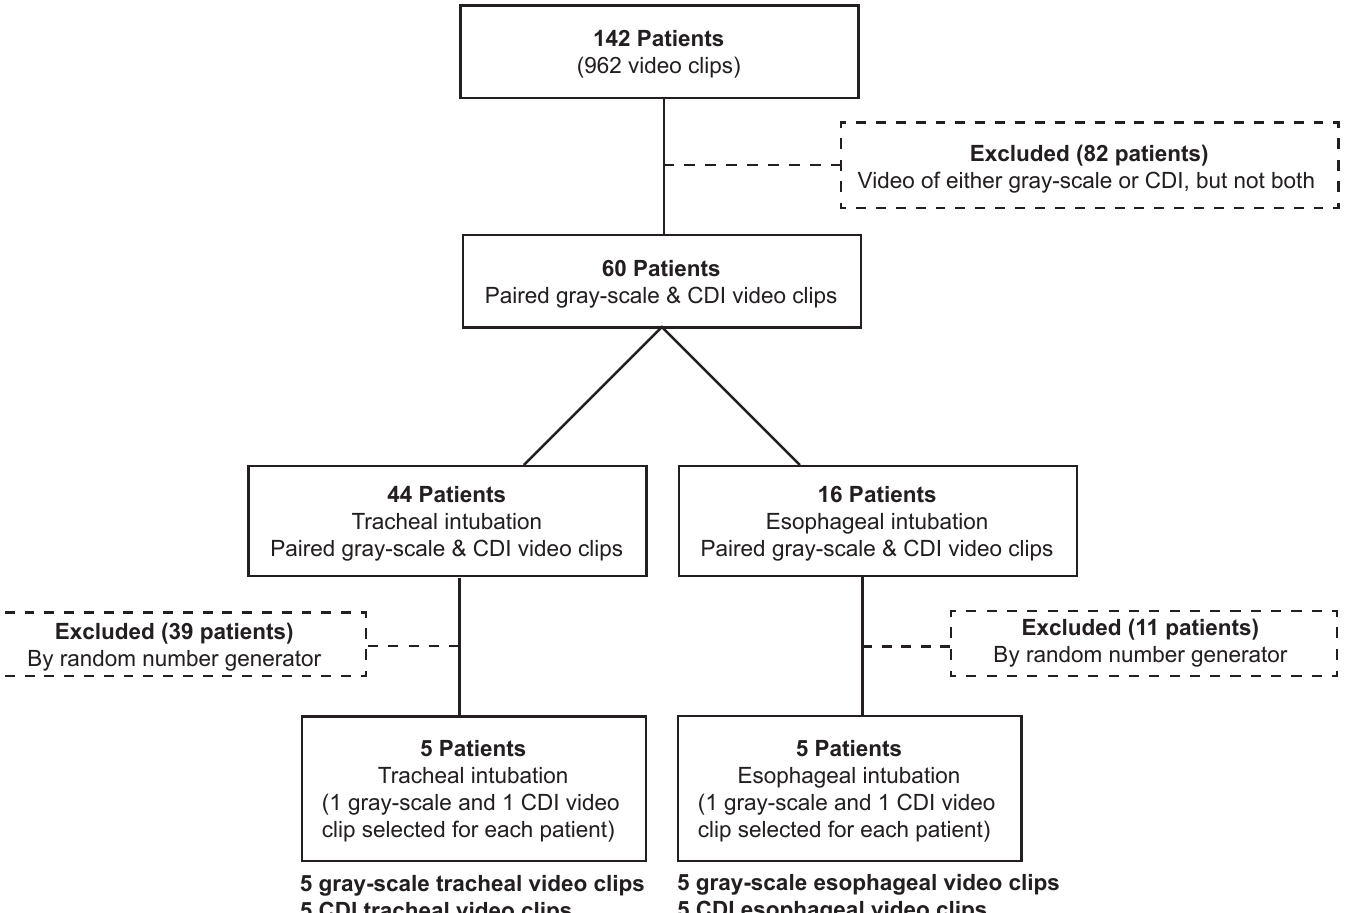
Figure 1. Selection of video clips used in an online assessment of clinician accuracy in determining tracheal versus esophageal endotracheal tube placement using color Doppler imaging (CDI) relative to grayscale imaging